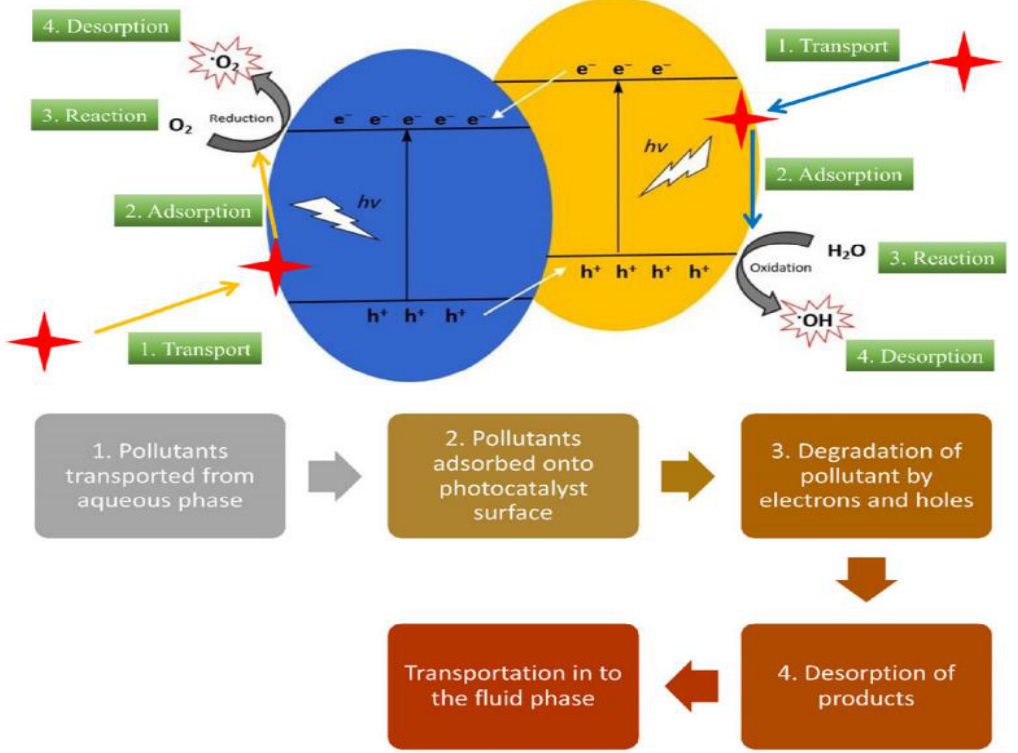
Figure 2. The process of dye-degradation mechanisms by photocatalysis, depicted graphically [91].